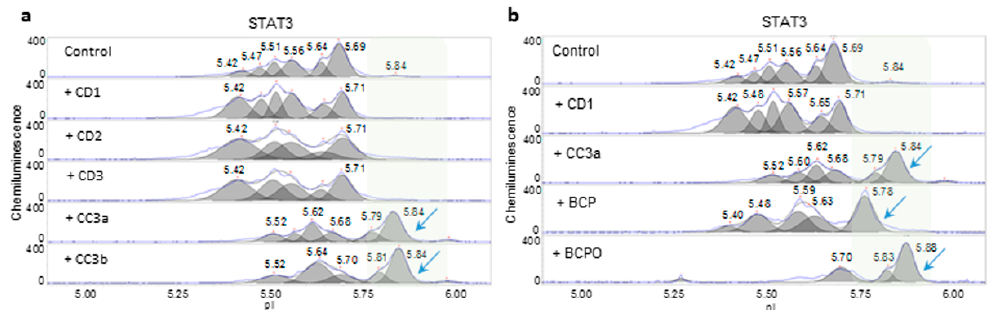
Figure 5. Assessment of the consistency of copaiba essential oils. ( a ) Opposite effects of copaiba essential oils CD1, CD2, and CD3 as compared with CC3a and CC3b on STAT3 phosphorylation. ( b ) β -Caryophyllene and β -caryophyllene oxide caused dephosphorylation of STAT3. Shaded backgrounds and blue arrows highlight right-shifted peaks, which indicate dephosphorylation of STAT3.